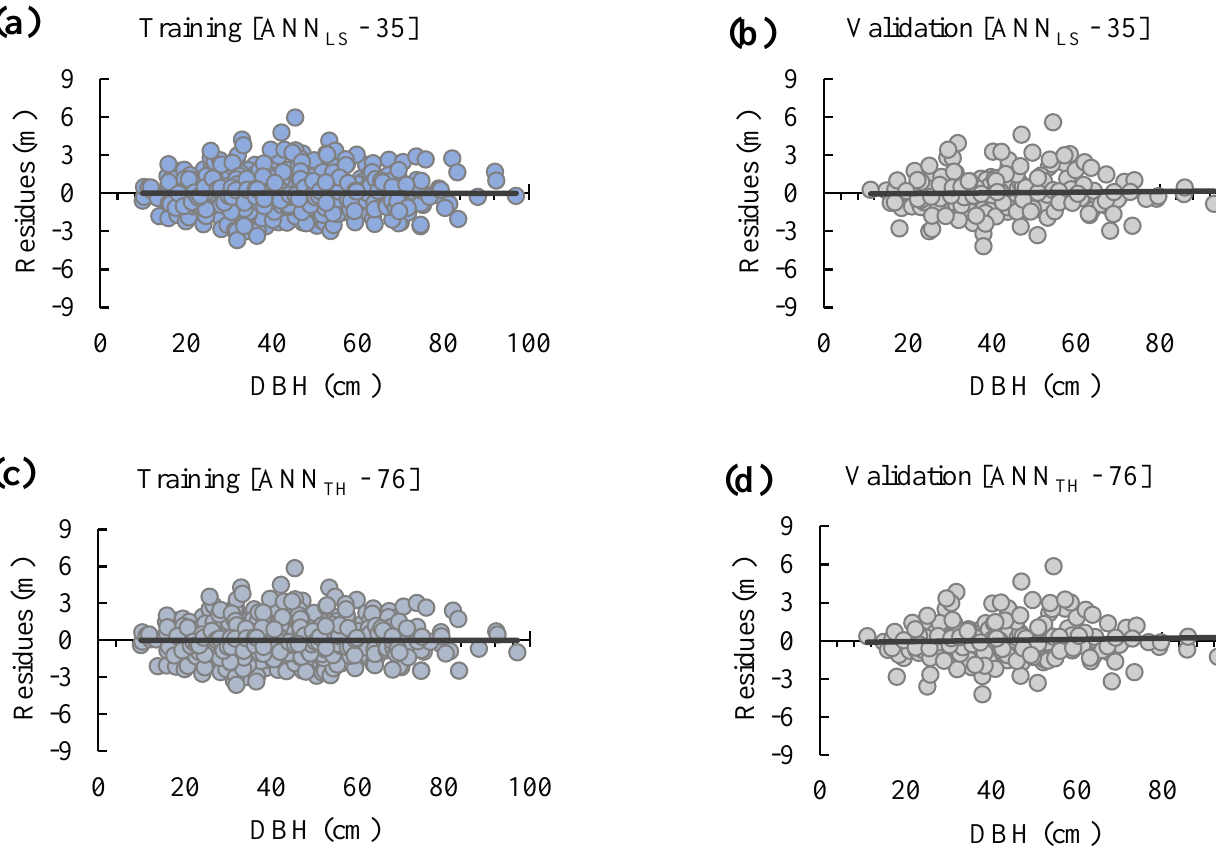
10 of 18 Table 3. Precision measures of the studied Artificial Neural Networks (ANN) variations for height estimation of Brazilian pine. Data Normaliza- tion